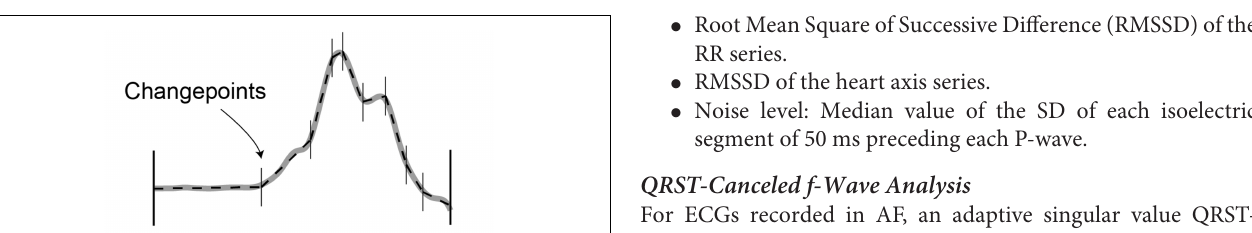
Spatiotemporal P-Wave Variability Analysis The spatiotemporal P-wave variability was assessed on all ECG leads after 0.5–80 Hz band-pass and 50 Hz notch